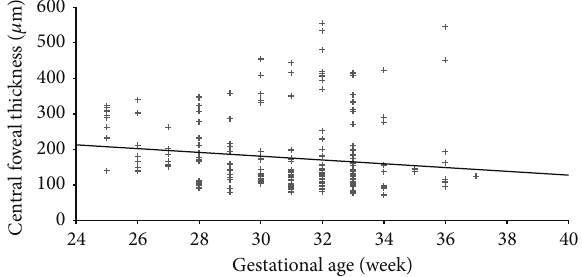
Figure 7: The correlation between central foveal thickness and gestational age ( 𝑃 = 0.025 , 𝑟 = −0.227 ) (Spearman correlation test).